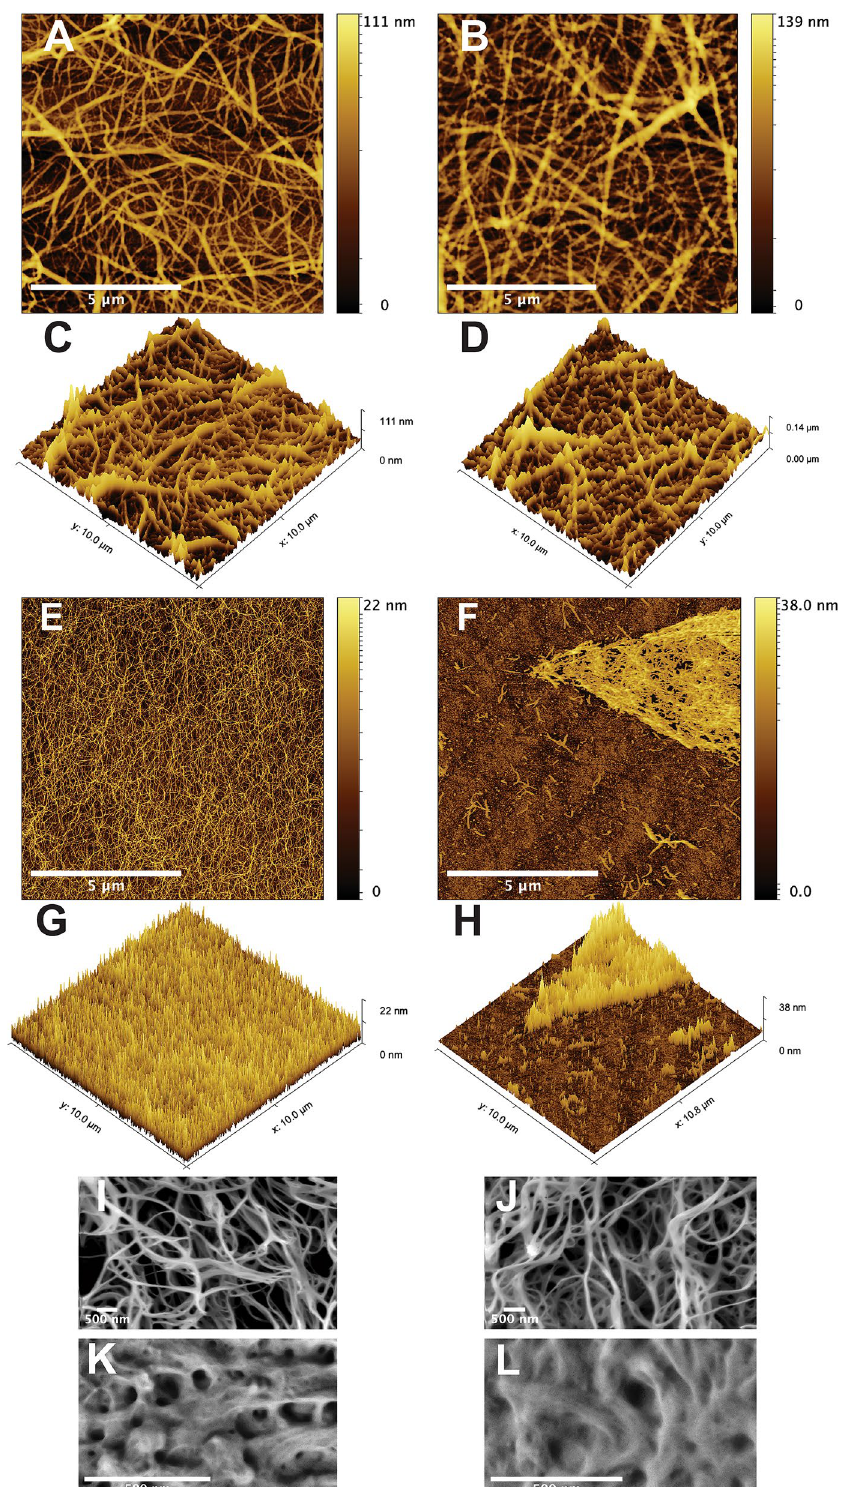
Figure 1. Hydrogel microstructure: Topographic atomic force microscopy (AFM) images of ( A ) fibrin hydrogel without COAM and ( B ) fibrin hydrogel with COAM. 3D AFM images of ( C ) fibrin hydrogel without COAM and ( D ) fibrin hydrogel with COAM. Topographic AFM images of ( E ) SAP hydrogel without COAM and ( F ) SAP hydrogel with COAM. 3D AFM images of ( G ) SAP hydrogel without COAM and ( H ) SAP hydrogel with COAM. Scanning electron microscopy (SEM) micrographs of ( I ) fibrin hydrogel without COAM, ( J ) fibrin hydrogel with COAM, ( K ) SAP hydrogel without COAM, and ( L ) SAP hydrogel with COAM. Color code scale in AFM images ( A – H ) represents fiber height. Scale bars in ( A , B , E , F ) = 5 µm, and in ( I , J , K , L ) = 500